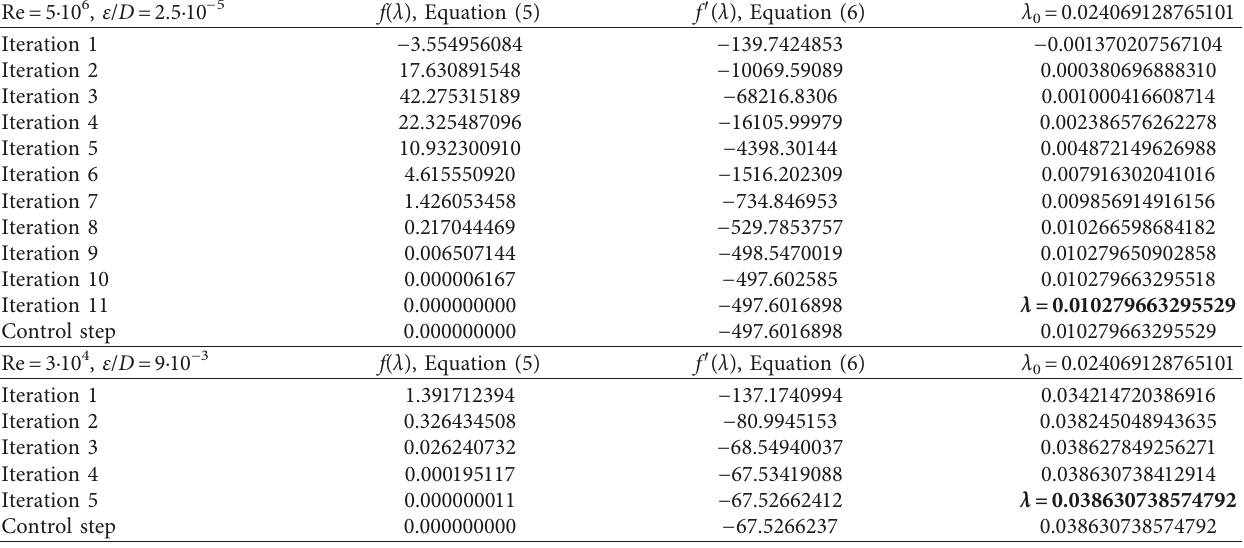
Table 2: Newton–Raphson procedure. Option 2: fixed initial starting point λ Equation (7), and analytical derivative f ′ ( λ ): Equation